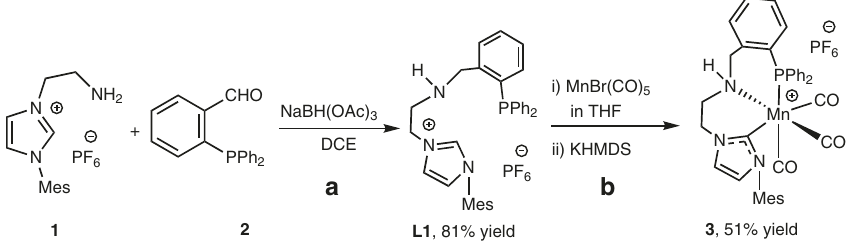
Fig. 2 Synthesis of Mn(I) complex 3. a Conditions: 1 (8 mmol), 2 (1 eq.), NaBH(OAc) 3 (2.5 eq.), DCE (20 mL), rt, 12 h. b Conditions: (i) L1 (0.5 mmol),